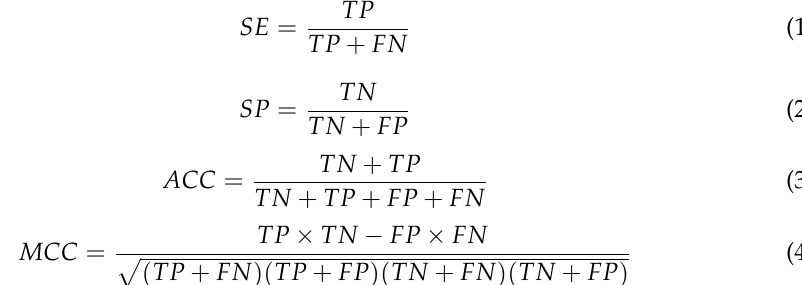
Table 1. Performance matrices of the full model.